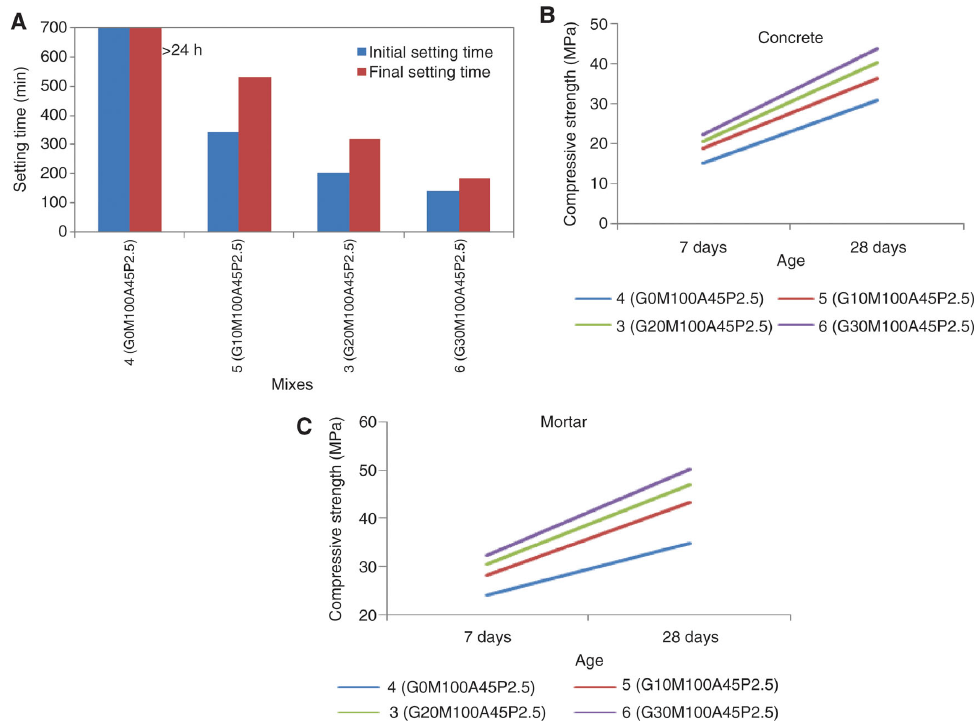
Figure 4: Effect of GGBFS on the setting time (A), compressive strength of geopolymer concrete and mortar (B) and